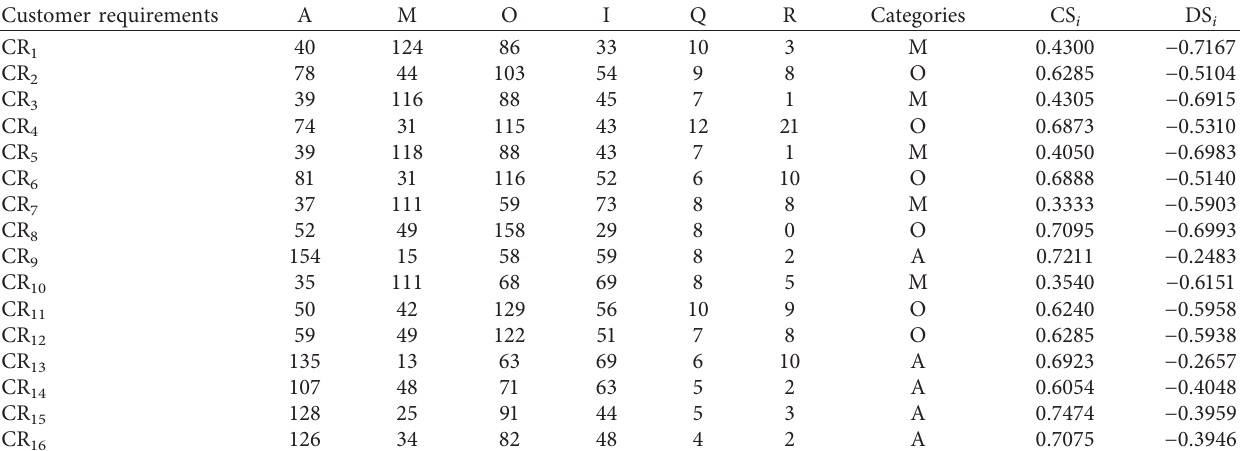
Table 2: Kano classification of customer requirement and the Better-Worse coefficient. Customer requirements